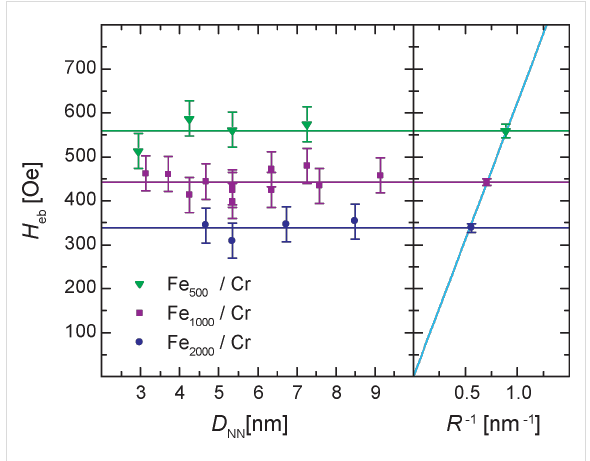
Figure 4: Left: H eb versus D NN for the three series of samples with different cluster sizes. D NN has no effect on H eb , while a pronounced effect is found for the size of the embedded clusters. Right: Average H eb versus R − 1 for the three cluster sizes showing a linear